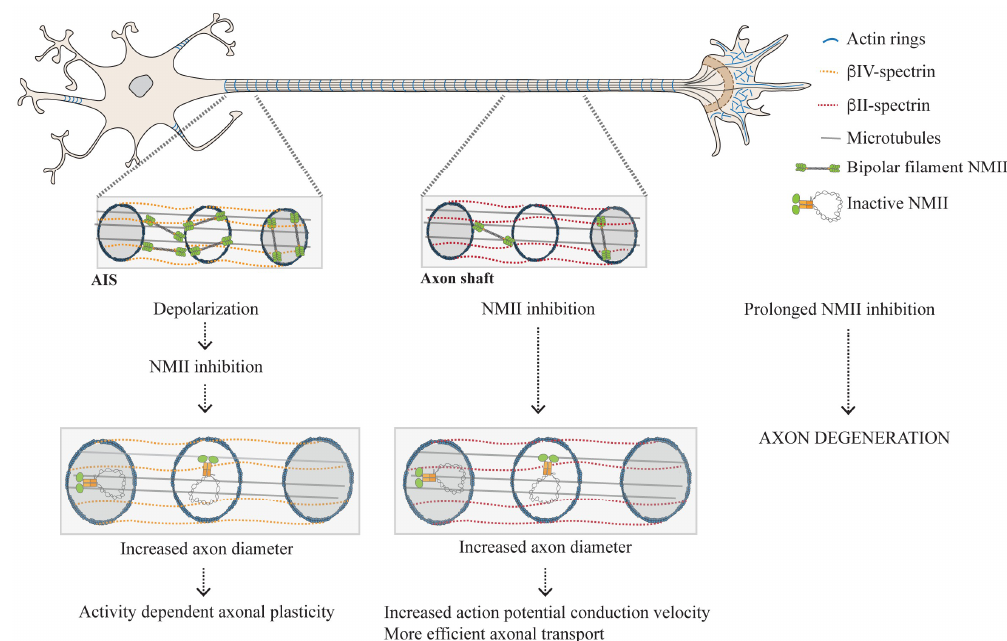
Figure 3. Schematic representation of the role of the actomyosin cytoskeleton in the control of axonal contractility. Phosphorylated myosin light chain is highly enriched at the AIS, where it may participate in the regulation of axon diameter during action potential firing. In the axon shaft, circumferential and longitudinal axon tension are also regulated by the actomyosin network. While pMLC forms circular periodic structures colocalizing with membrane periodic skeleton (MPS) actin rings, NMII heavy chains appear mostly distributed as multiple filaments with approximately 300 nm of length along the longitudinal axonal axis, crosslinking adjacent actin rings (probably providing for tension); NMII filaments spanning individual rings may also exist (and provide for contraction).